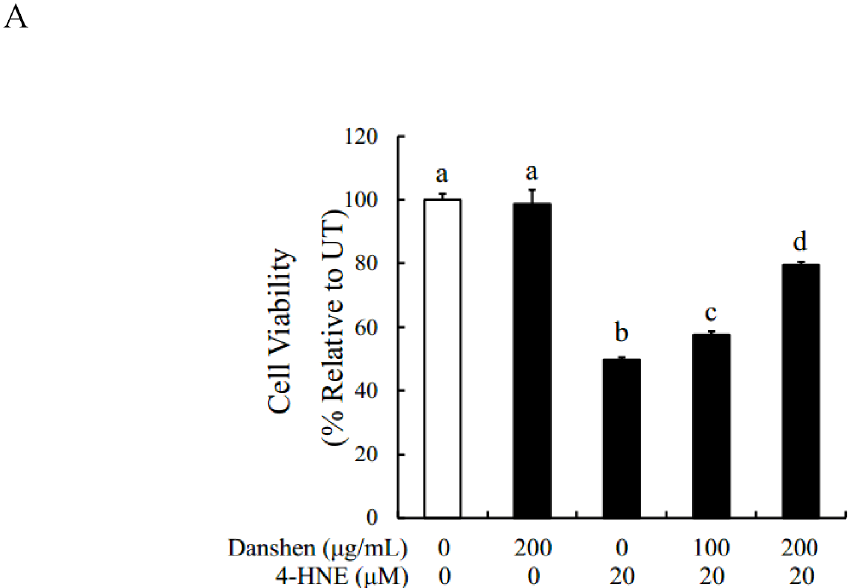
Fig 4. Danshen supplementation protects hepatocytes from 4-HNE-elicited cell death. A . Danshen significantly prevents 4-HNE inducedLDH release from HepG2 cells. HepG2 cells are pretreatedwith 100 or 200 μ g/mL Danshenfor 2 hours before 4-HNE addition.LDH release is measured 16 hours later. All values are denotedas the mean ± SD from three or more independent studies. Bars with different letters differ significantly (p <